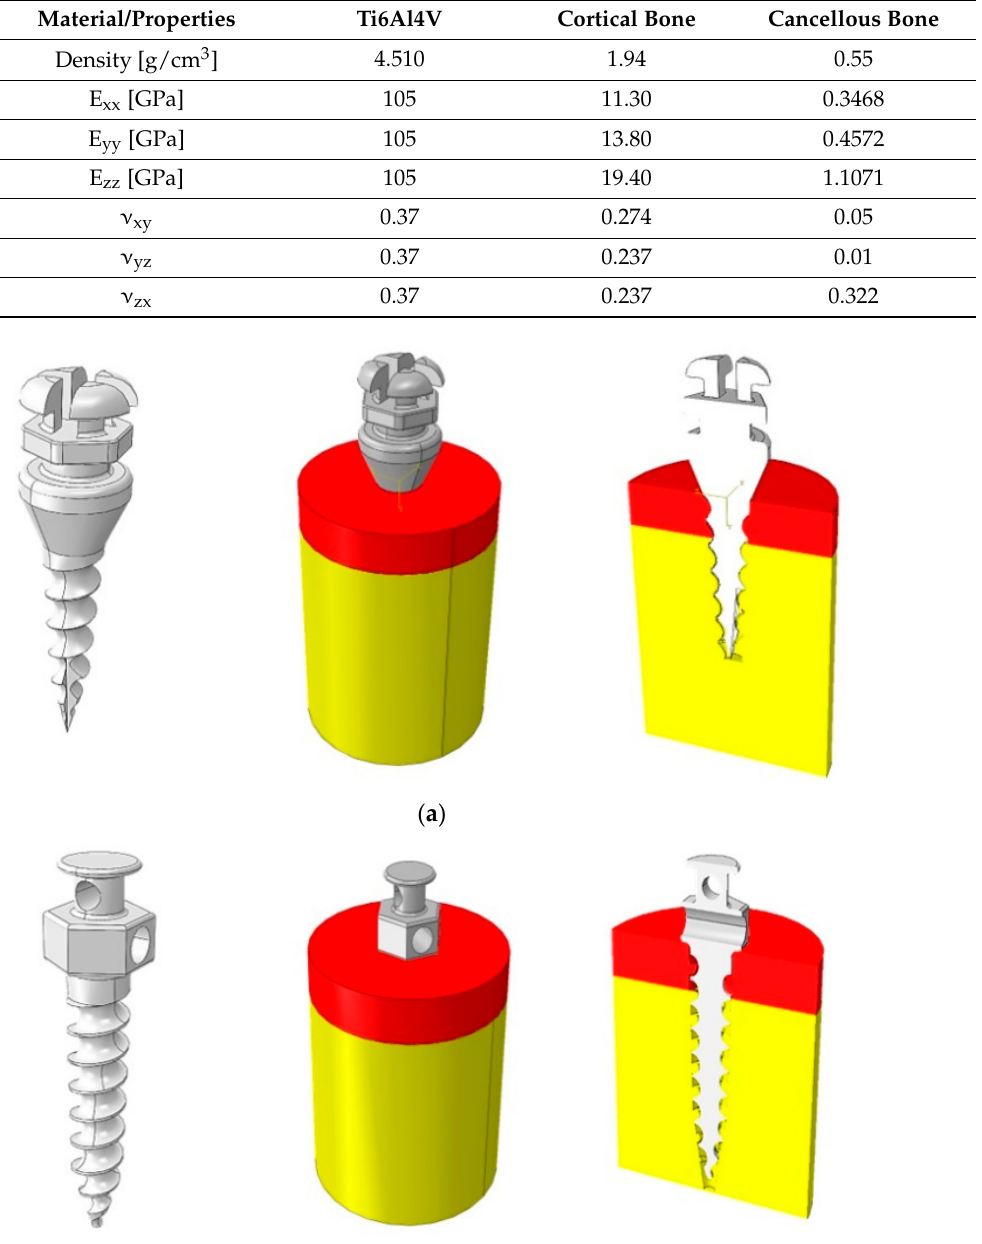
Table 2. Properties of materials.